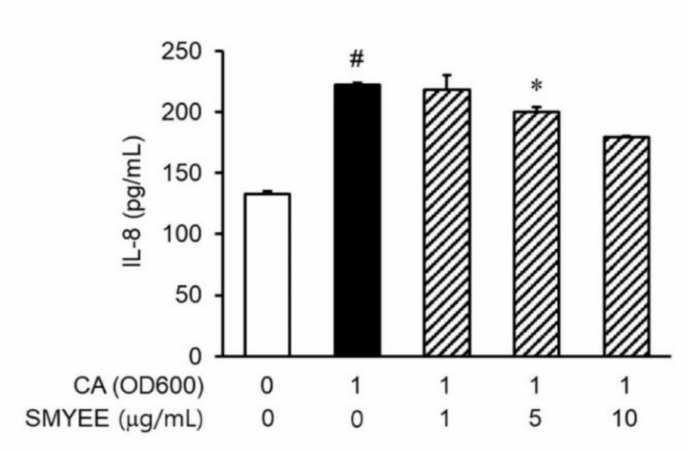
Figure 3. E ff ects of Sargassum miyabei Yendo ethanolic extract (SMYEE) on interleukin (IL)-8 production in Cutibacterium acnes ( C. acnes )-induced HaCaT cells seeded at 2 × 10 5 cells / mL and incubated with various concentrations (1 µ g / mL, 5 µ g / mL, and 10 µ g / mL) of SMYEE for 30 min, followed by C. acnes stimulation (1 optical density unit at 600 nm [OD 600 ]). After stimulation with C. acnes for 24 h, IL-8 production by HaCaT cells was determined via enzyme-linked immunosorbent assay (ELISA) using the supernatant. The data are means ± standard error of the mean (SEM) and are representative of the results obtained in three independent experiments. # p < 0.05 vs. the no-treatment group; * p < 0.05 vs. the C. acnes group. CA: C. acnes .